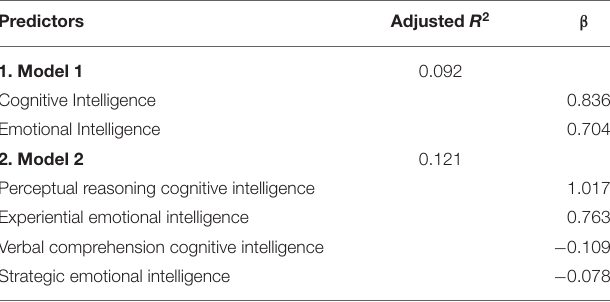
TABLE 2 | Results of multiple regression analyses predicting decision-making performance in older adults. Predictors